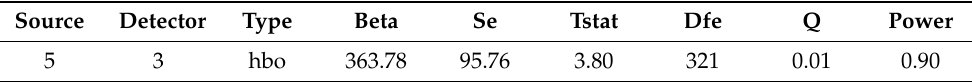
Table A10. t -test statistics for each channel (source–detector pair). West Intense Stretch A and B– Warrior 2 Right.